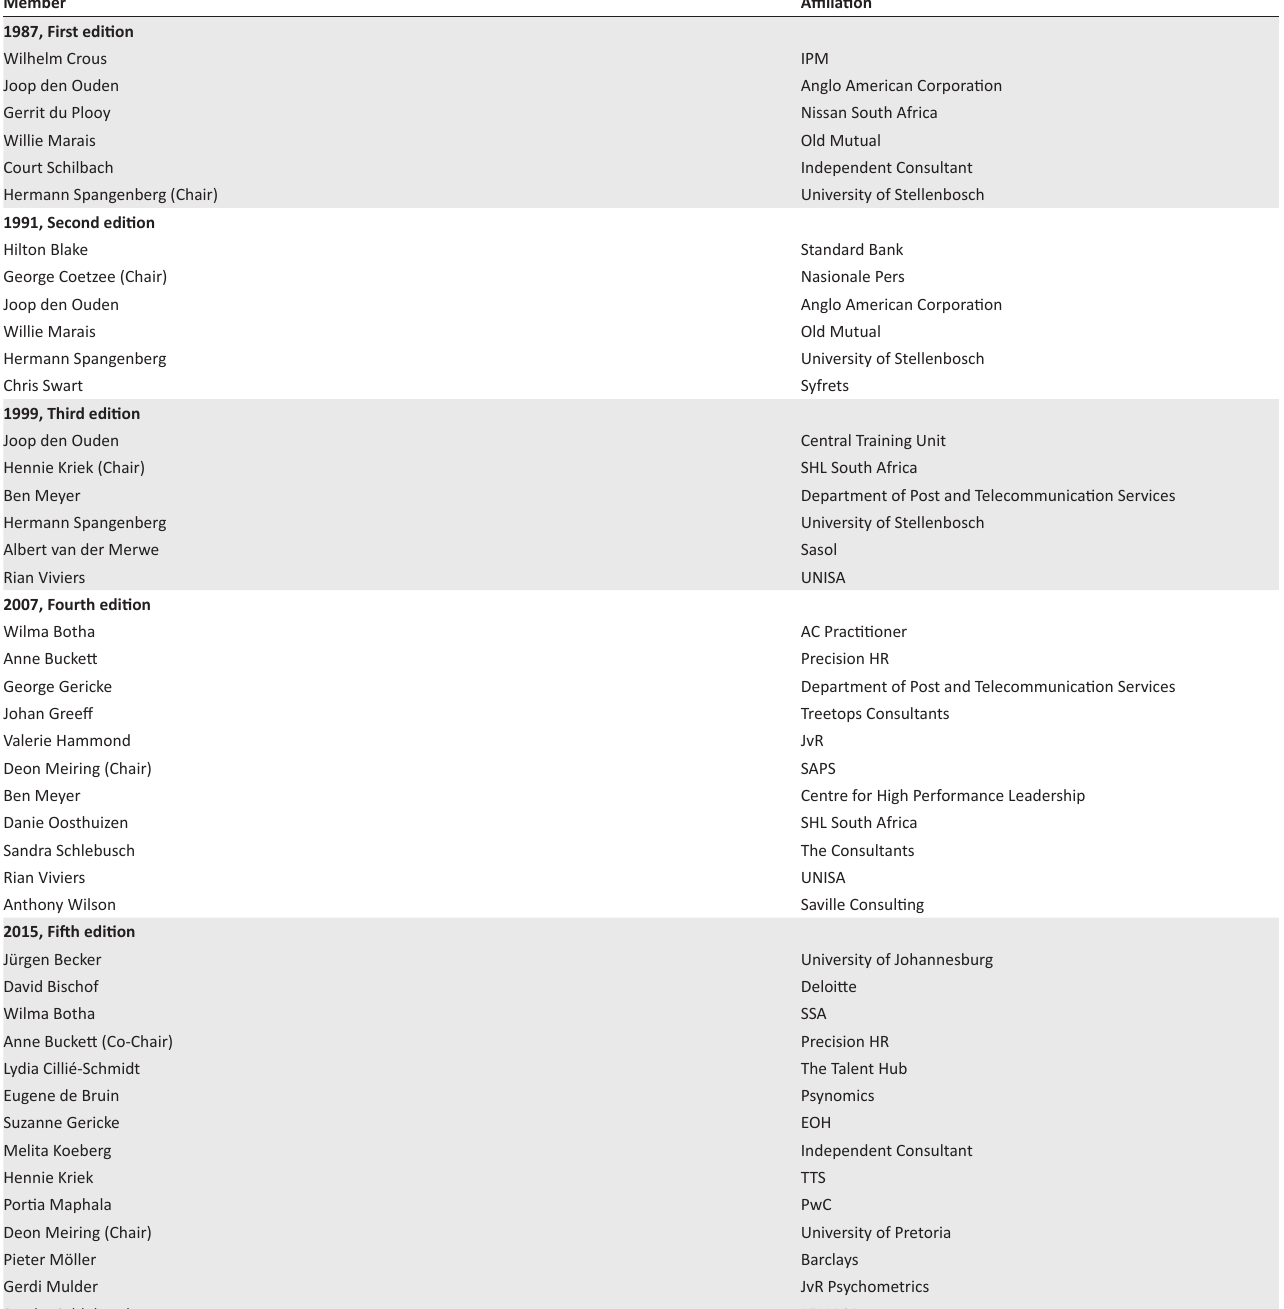
Table A1-1: Past Taskforce